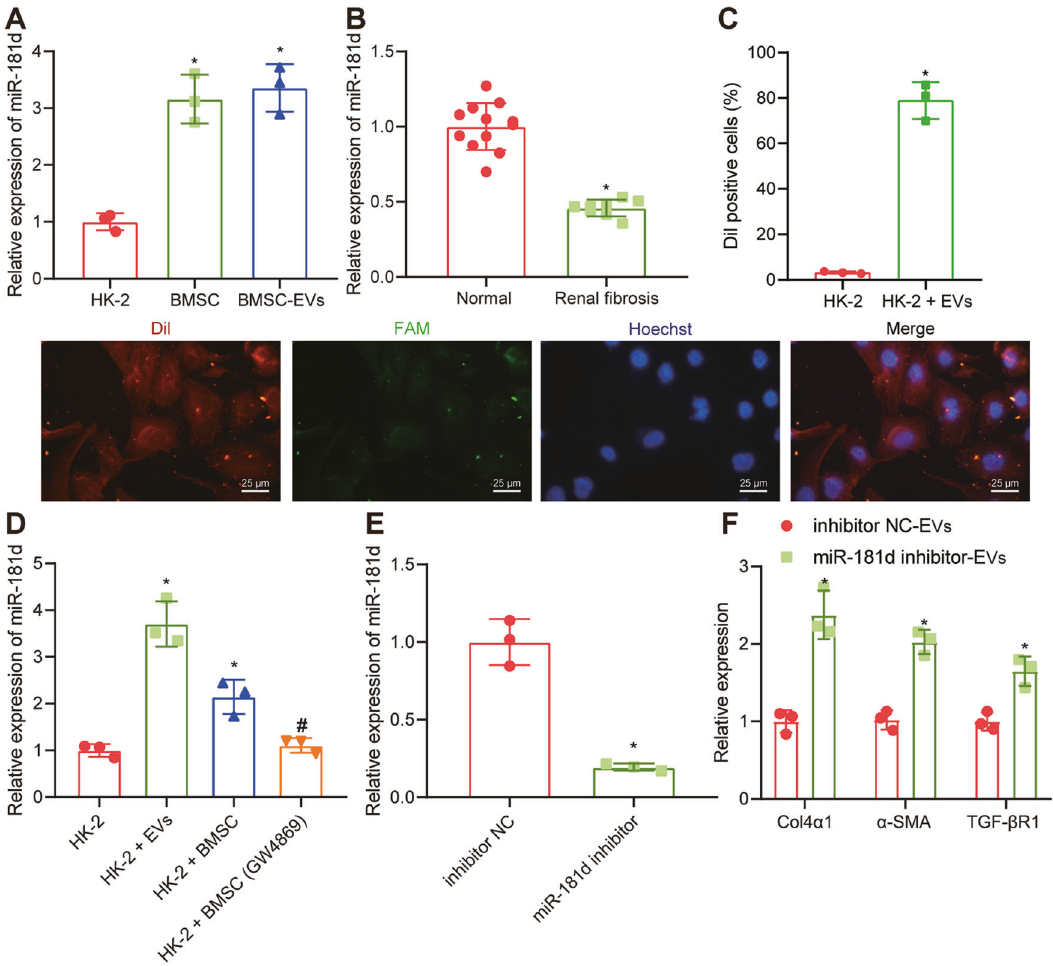
Fig. 2 BMSC-EVs transfer miR-181d to inhibit fi brosis in HK-2 cells. A miR-181d expression in HK-2 cells, BMSCs or BMSC-EVs. * p < 0.05 vs . HK-2 cells. B RT-qPCR analysis of miR-181d expression in renal tissues from patients with renal fi brosis ( n = 8; two cases at stage I, three cases at stage II, two cases at stage III, and one case at stage IV) or healthy controls ( n = 12). * p < 0.05 vs . healthy controls. C Immuno fl uorescence detection of miR-181d transfer by BMSC-EVs into HK-2 cells. * p < 0.05 vs . HK-2 cells. D RT-qPCR analysis of the expression of miR-181d in HK-2 cells after co-culture of EVs and BMSCs or those treated with GW4869. * p < 0.05 vs . HK-2 cells. # p < 0.05 vs . HK-2 cells co-cultured with BMSCs. E RT-qPCR analysis of miR-181d expression in BMSCs in the presence of miR-181d inhibitor. * p < 0.05 vs . inhibitor NC. F RT-qPCR analysis